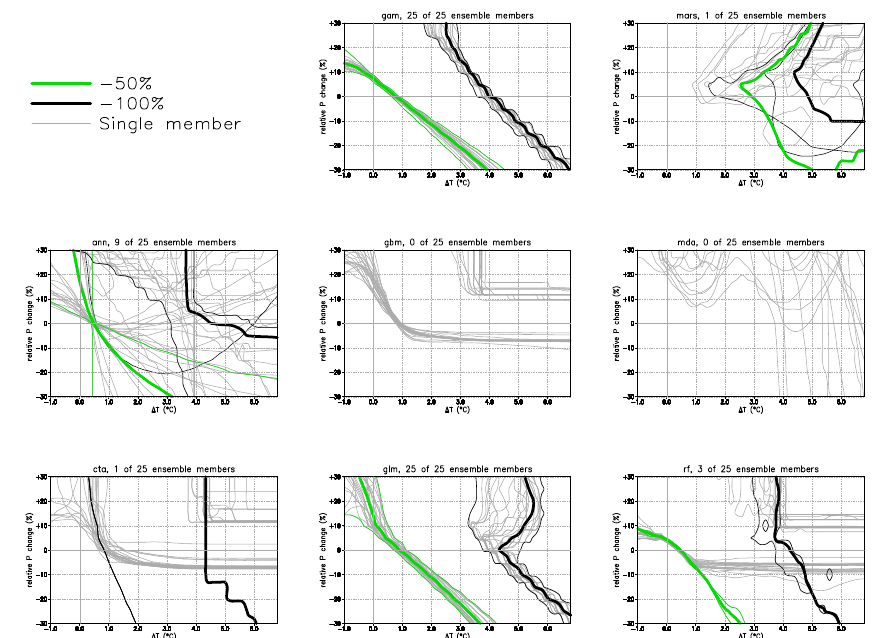
Fig. A1. Impact response surfaces showing the combinations of changes in annual mean temperature and precipitation for which half (green lines) and all (black lines) of the simulated palsa area becomes unsuitable relative to the simulated distribution for the 1961–1990 baseline period for eight climatic envelope modelling techniques. The thicker lines show values for ensemble averages of all plausible models (see text) calibrated for the 1951–1980 baseline period, the thinner lines show the range for the ensembles. Impact response surfaces of individual models, including those that failed the plausibility criteria, are shown with gray lines. The name of the technique and the number of plausible models is given as a title for each sub-graph.